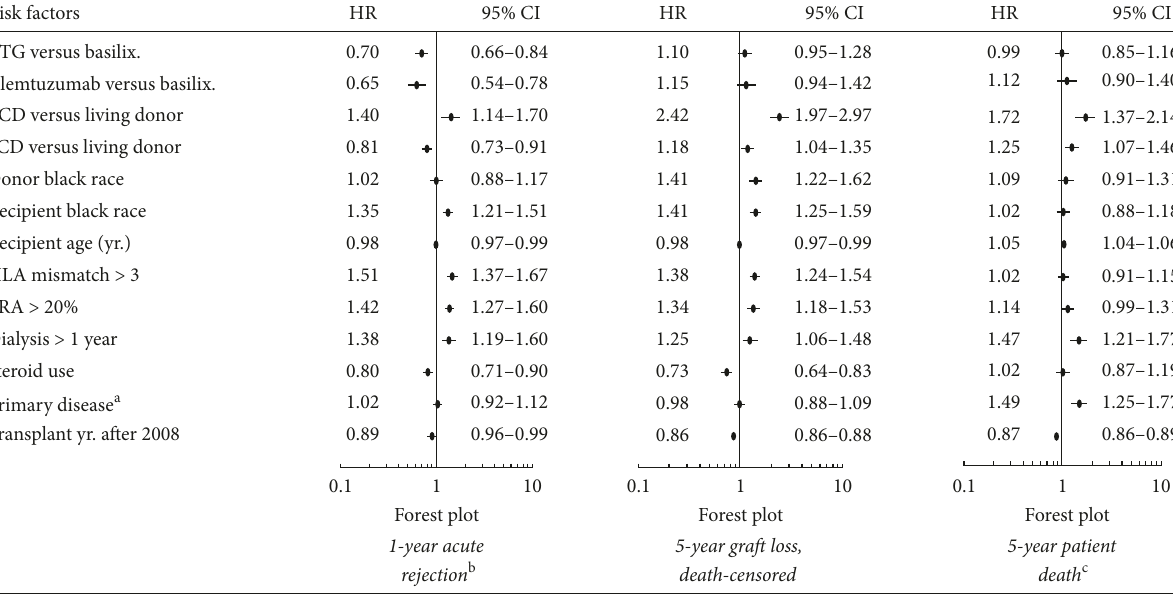
Figure 2: Kidney retransplantation outcomes: main Cox model (no